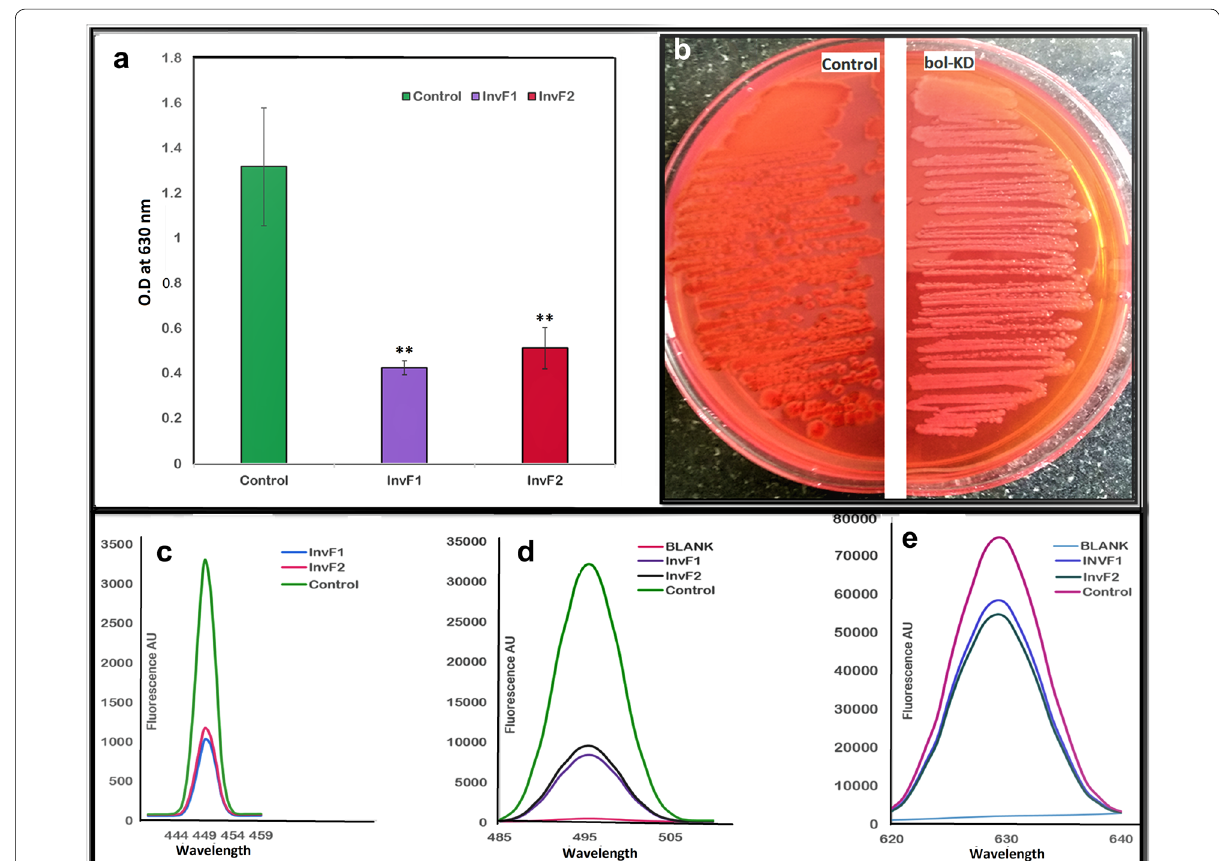
Fig. 3 a Biofilm quantification with Crystal violet assay. The data represent an average of triplicate experiments sided) (** p < 0.005, t-test, two sided). b Congo red agar plates showing a whitish colony in the treated cells, an indicator of reduction in the curli production. c ThT fluorescence spectra. d Congo red fluorescence spectra. e TBO fluorescence